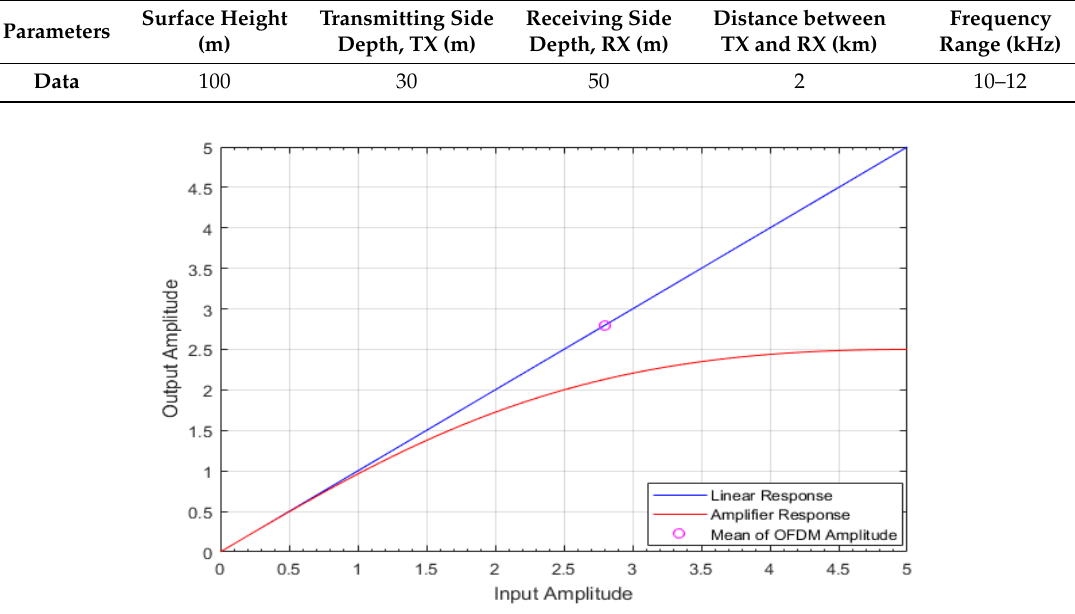
Figure 6. Power amplifier (PA) solid-state model used at the transmitter.